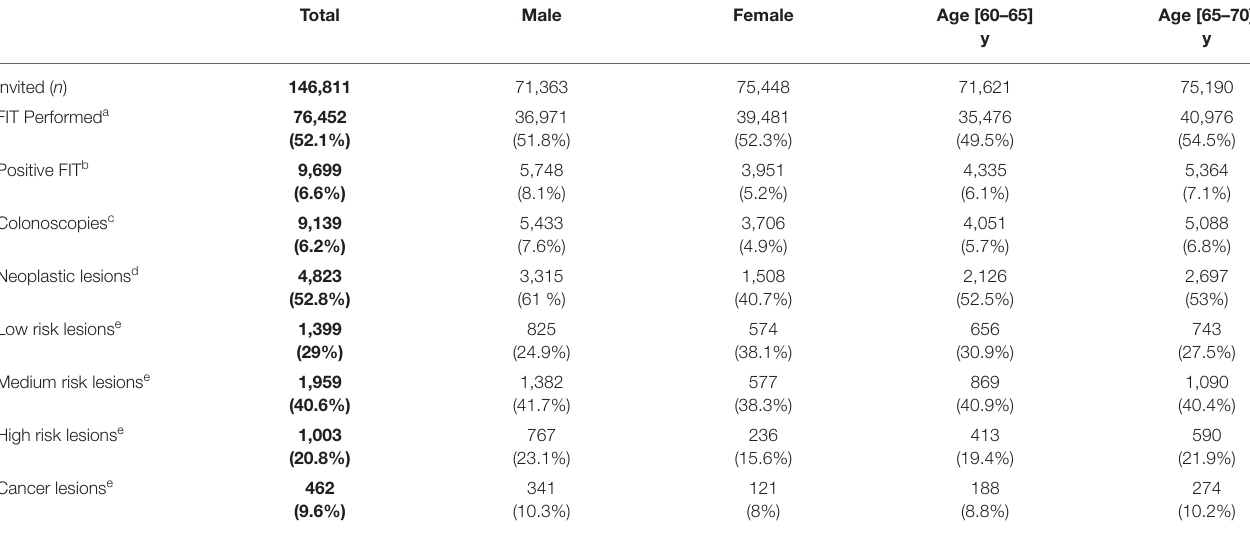
TABLE 1 | Screening results for the study population and